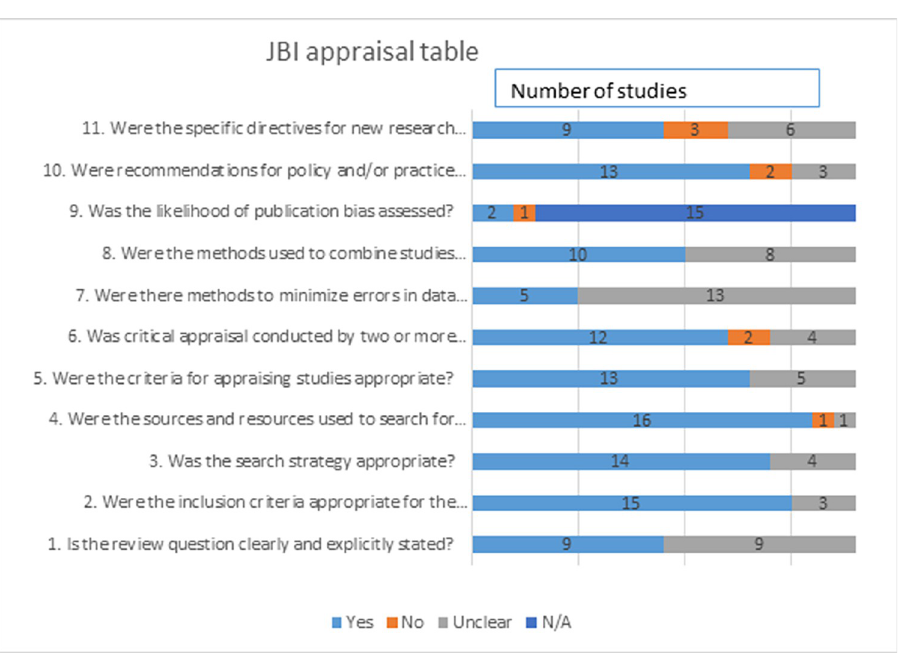
Fig 2. Overview of JBI appraisal table. The Figure outlines the results of using the JBI Critical Appraisal Checklist for Systematic Reviews and Research Synthesis (Copyright JBI 2020) on the 15 selected articles.